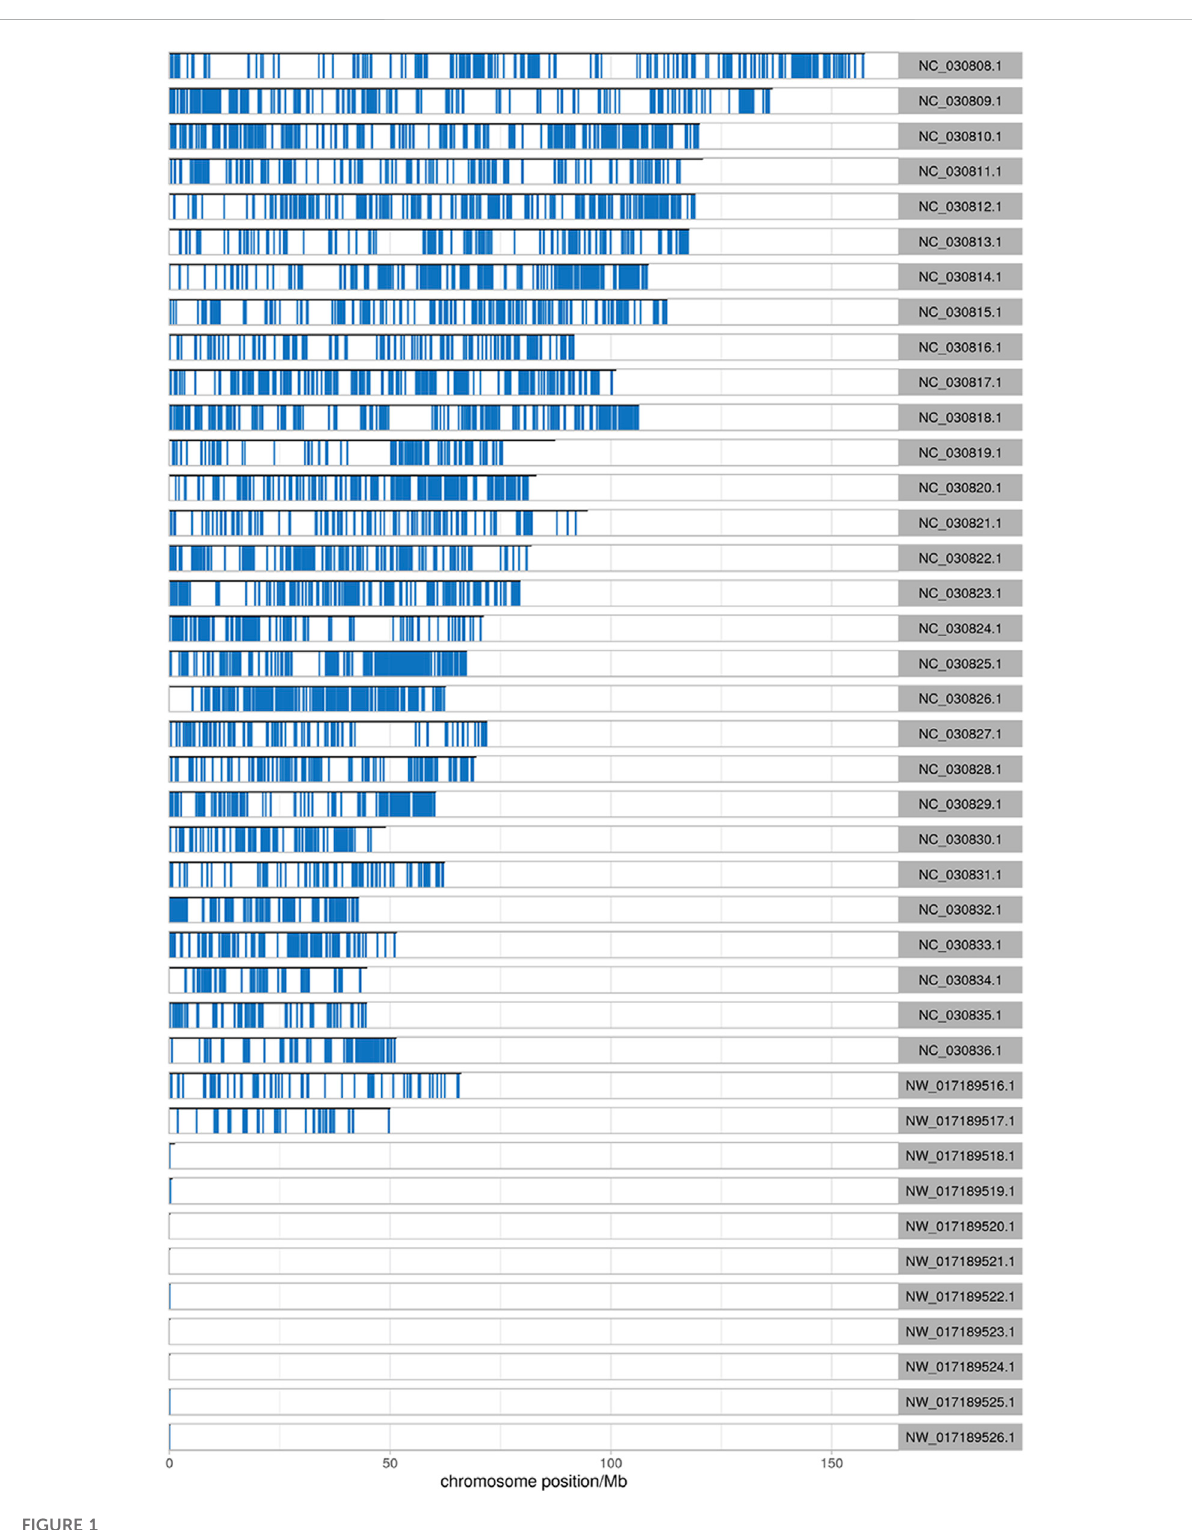
Frontiers in Cell and Developmental